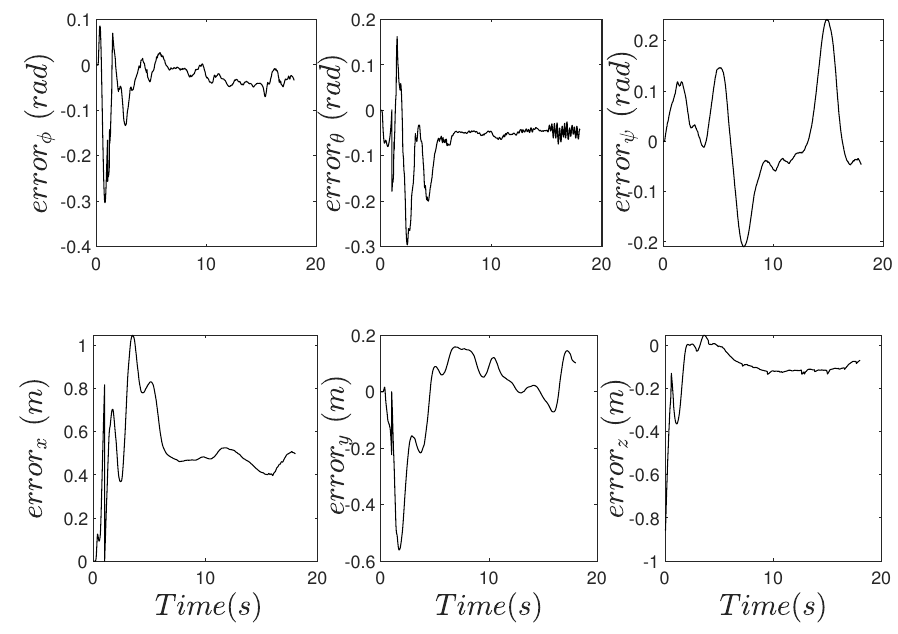
Figure 5. Error, reference versus variable